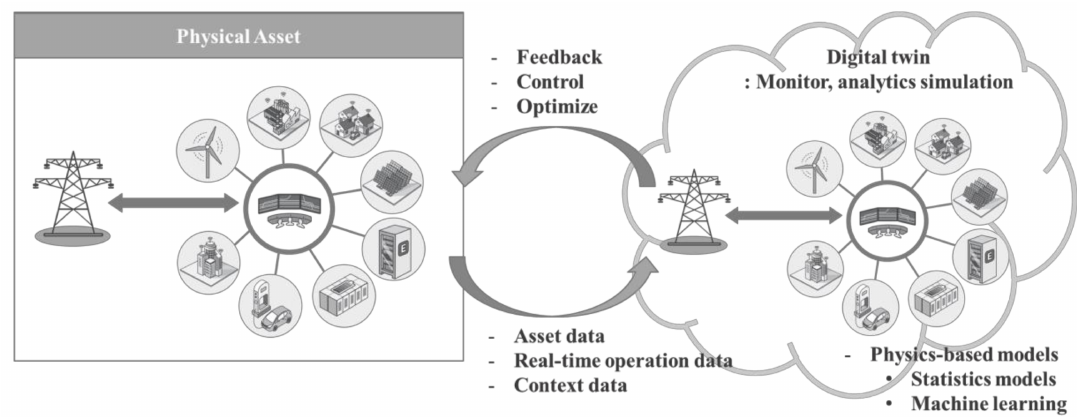
Figure 1. Digital twin concept for